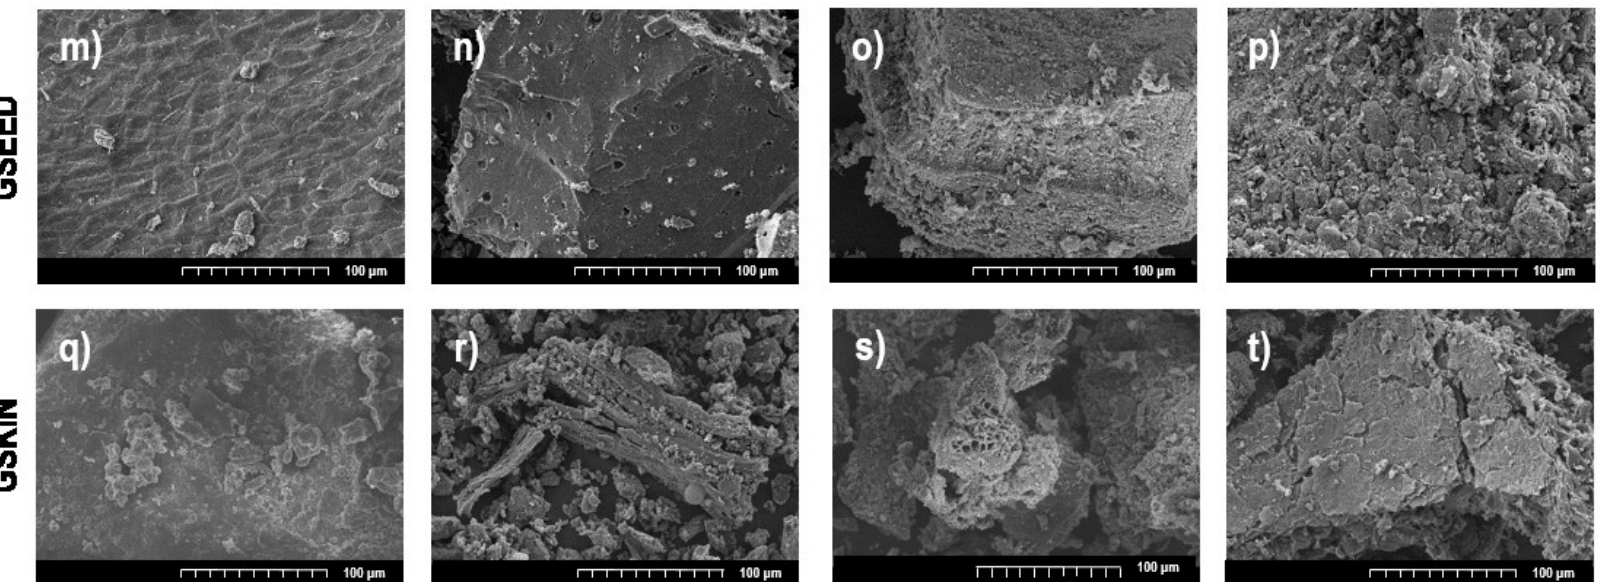
Figure 4. SEM micrographs of the untreated, pyrolyzed (1200), pretreated with HTC (HTC_1200) and pretreated with acid and later with HTC (PHOS_HTC_1200) samples of corn cob ( a – d ), apple pomace ( e – h ), olive mil solid waste ( i – l ), defatted dried grape skin ( m – p ) and dried grape skin ( q – t ),